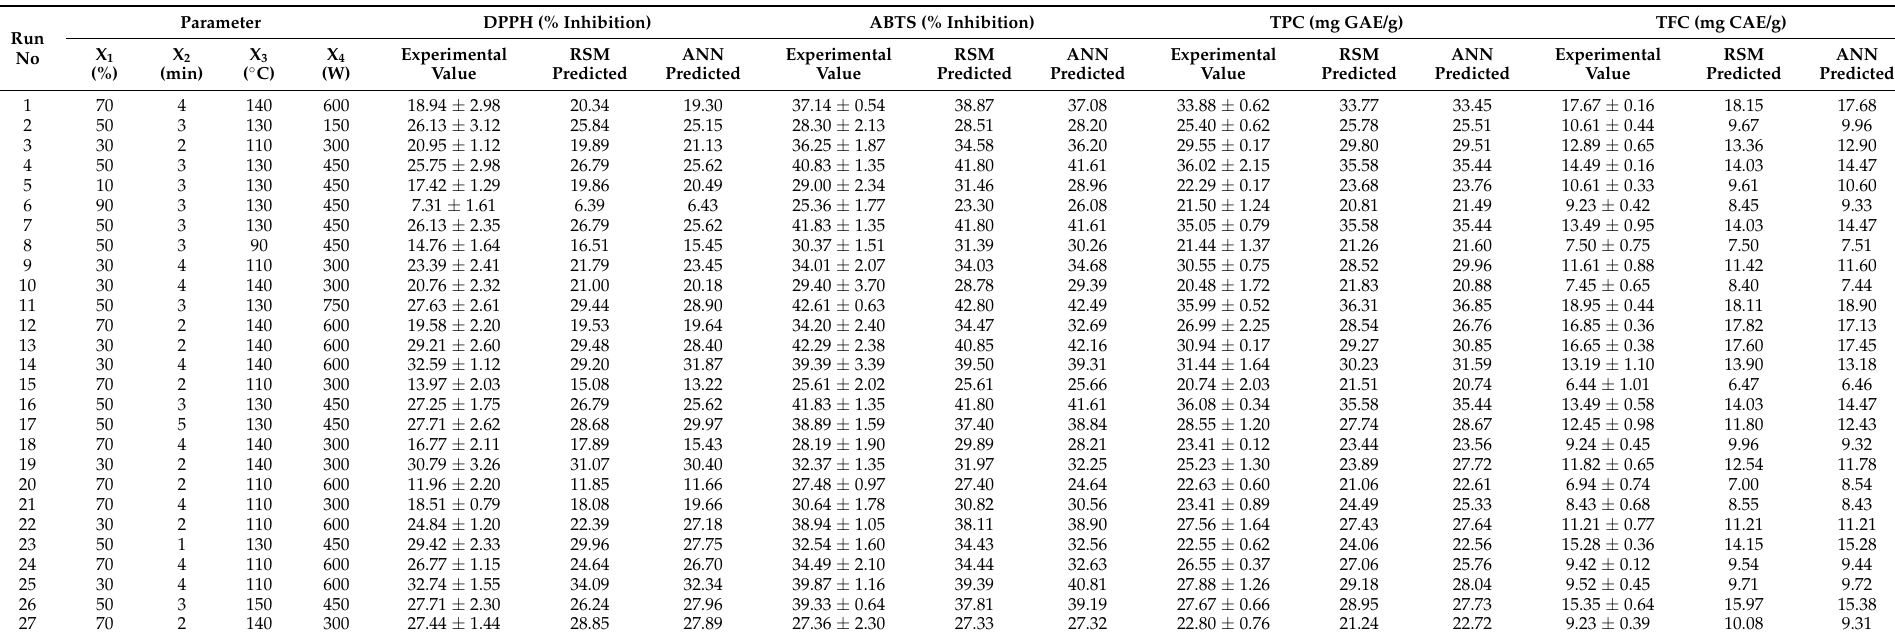
Table 1. Central composite design (CCD) for independent variables and corresponding target responses